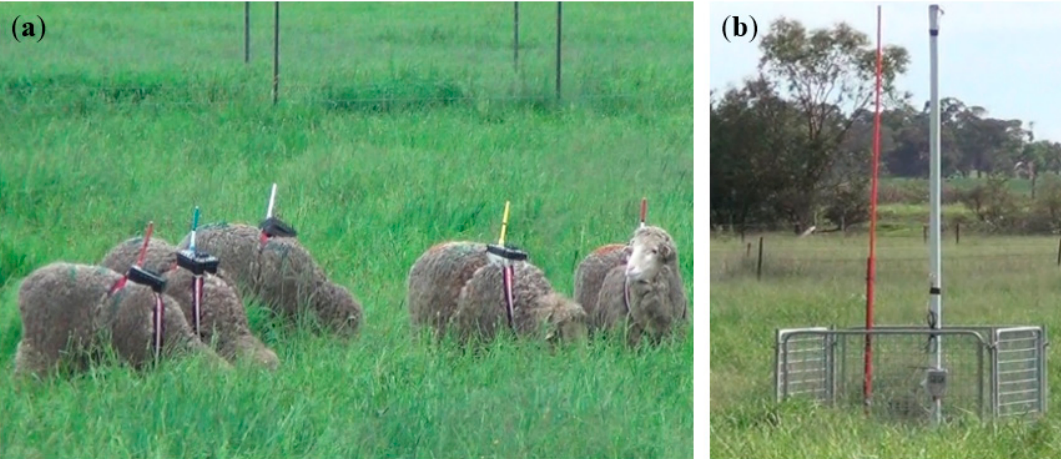
Figure 4. RTK rovers fitted on the back of sheep via harnesses ( a ), and fixed base station ( b ) in the middle of the paddock. The two masts ( b ) were for the GNSS amplified antenna, and RTK correc- tion transmitter.